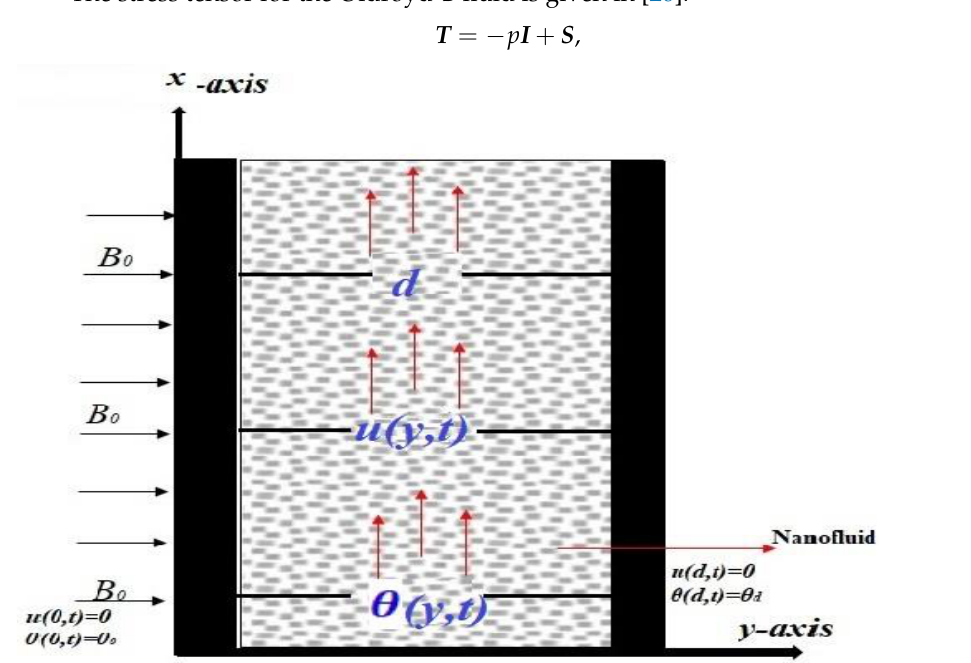
Figure 1. Geometry of the problem.